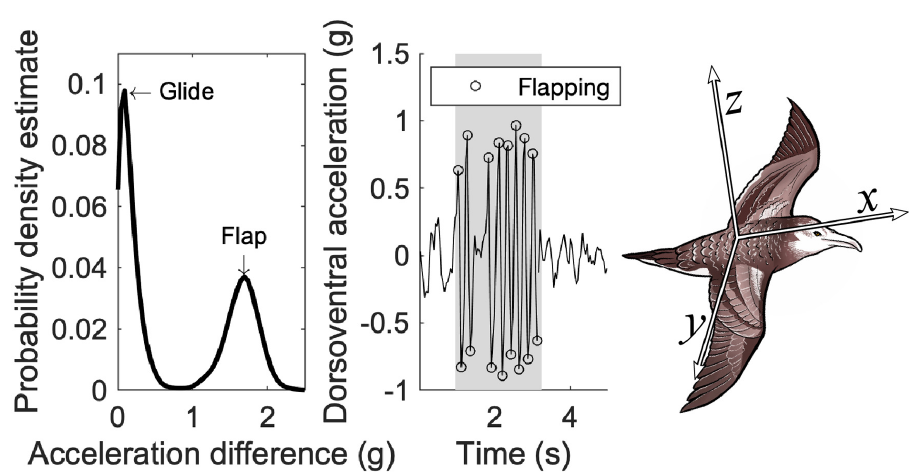
Fig 1. Flapping detection. An example of the flapping detection method for one AxyTrek tagged individual. The example bird (right) has three arrows showing the acceleration signals recorded and their orientation. x represents the longitudinal axis, z the dorsoventral, and y the lateral. The probability density estimate calculated by a kernel smoothing function of the difference in dynamic dorsoventral acceleration during estimated flight periods (left) showing flapping (smaller peak) and gliding (larger peak). Removing peaks and troughs with a difference less than the inter-peak trough isolates flapping behaviour (middle). Selected peaks and troughs (circled) separated by a duration of less than 0.5 seconds are grouped into flapping bouts (grey